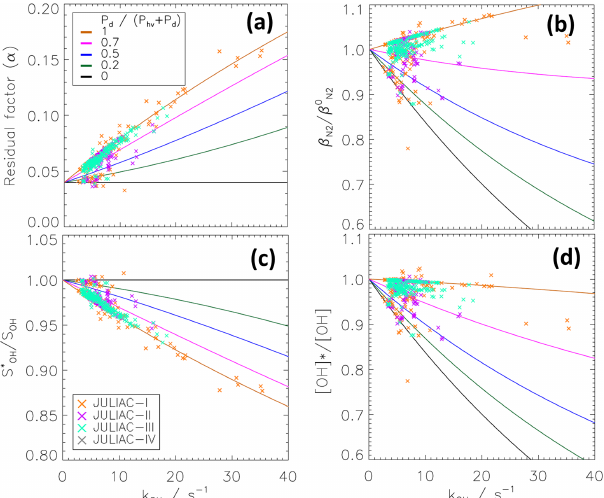
Figure 10. Modelled k OH dependence of the CMR properties for the atmospheric chemical conditions during the JULIAC periods in different seasons of 2019. Here, the model for a homogeneously mixed scavenger was applied. See Fig. 7 for further explanations of (a–c) . Panel (d) shows the ratio of corrected to uncorrected am- bient OH concentrations, if the k OH dependence of α and β N taken into